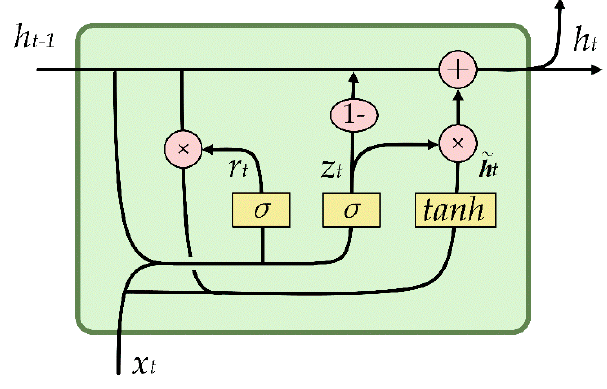
Figure 8. Gated recurrent unit (GRU) cell architecture.